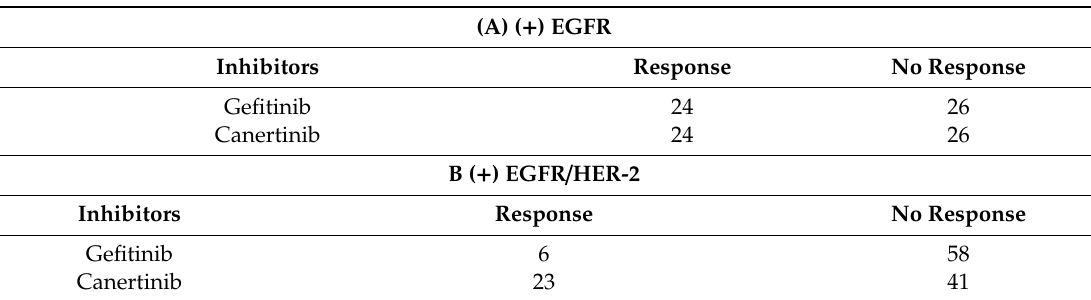
Table 7. Total responsiveness of EGFR and EGFR and HER-2 positive cells are compared between gefitinib and canertinib. Numbers of decrease in PCNA, EGFR, pEGFR, HER-2, pHER-2, pERK, and pAKT in EGFR positive cells ( A ) and EGFR and HER-2 positive cells ( B ) are counted, and data are subjected to statistical analysis, using Fisher’s exact test.